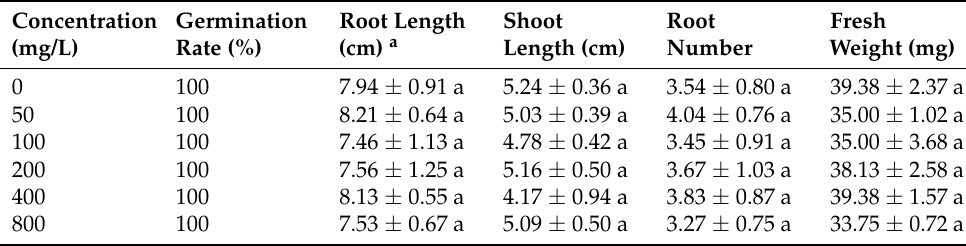
Table 5. The germination rate, root length, shoot length, root number, and fresh weight, of 7-day-old seedlings of rice germinated from seeds treated with different concentration of blank DMON–GA– Fe(III)